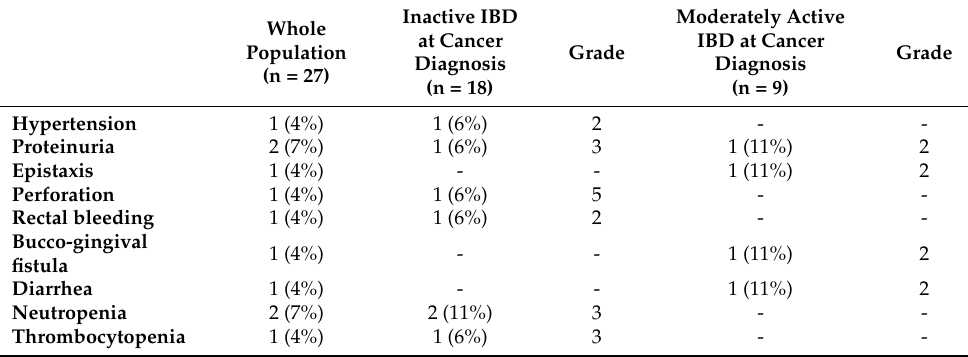
Table 4. Toxicities of bevacizumab and chemotherapy in patients with